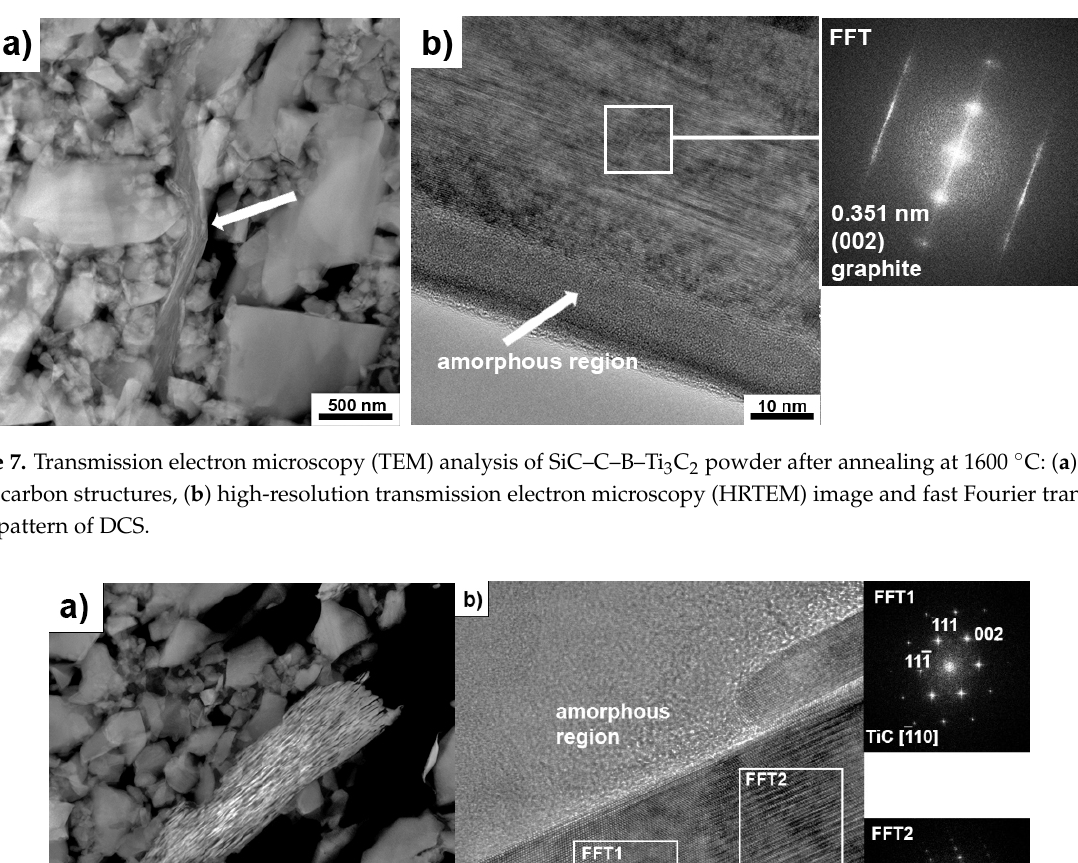
Figure 8. Transmission electron microscopy (TEM) analysis of SiC–C–B–Ti 3 C 2 powder after annealing at 1600 °C: ( a ) Porous layered structures, ( b ) high-resolution transmission electron microscopy (HRTEM) image and fast Fourier transform (FFT) pattern of porous layered structures.